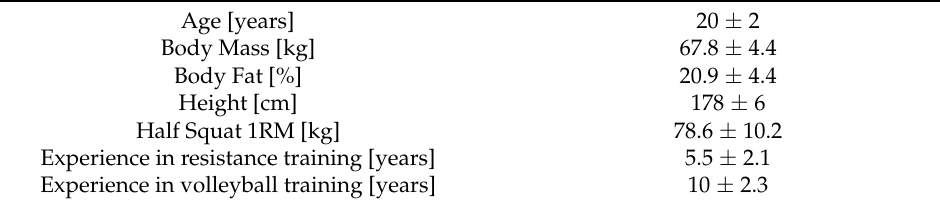
Table 1. Descriptive characteristics of the study